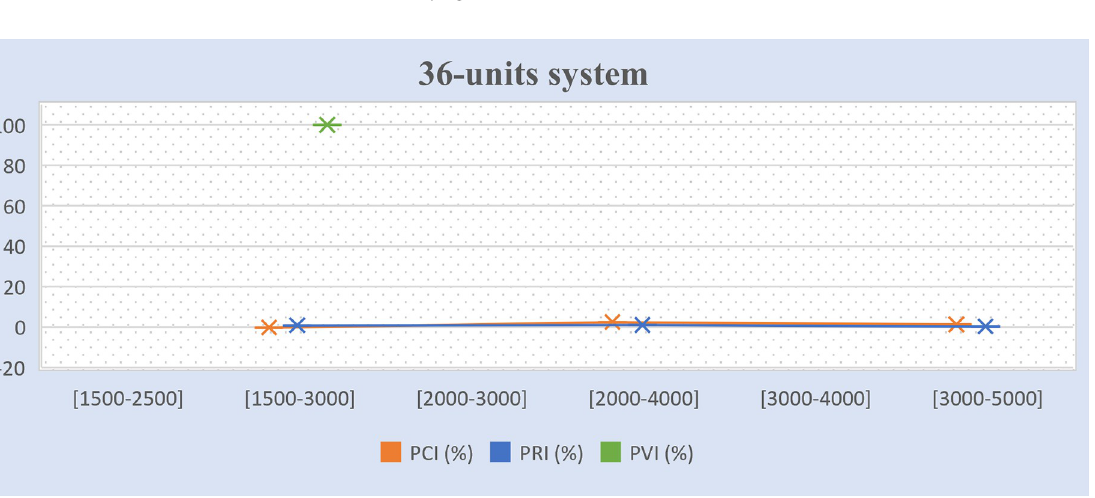
Fig 5. Percentage of improvement in cost, reliability, & violation for GMS model IV with 36-units system.